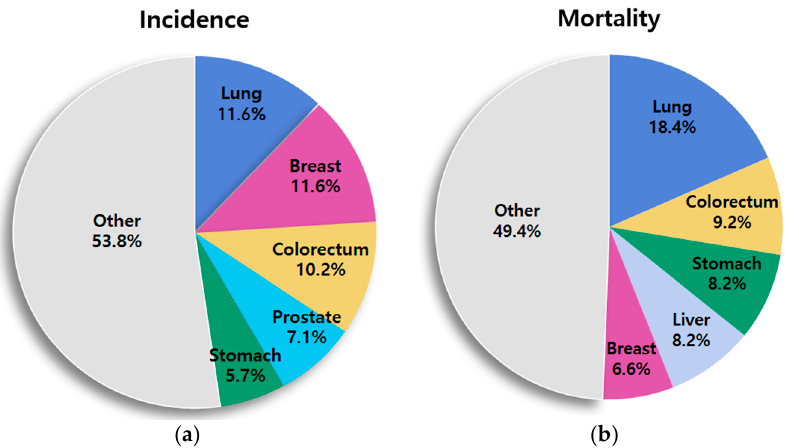
Figure 1. Distribution of cases and deaths for the five most common cancers in 2018: ( a ) incidence and ( b ) mortality.